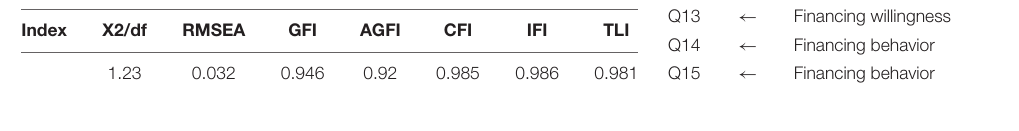
TABLE 8 | Results of confirmatory factor analysis.